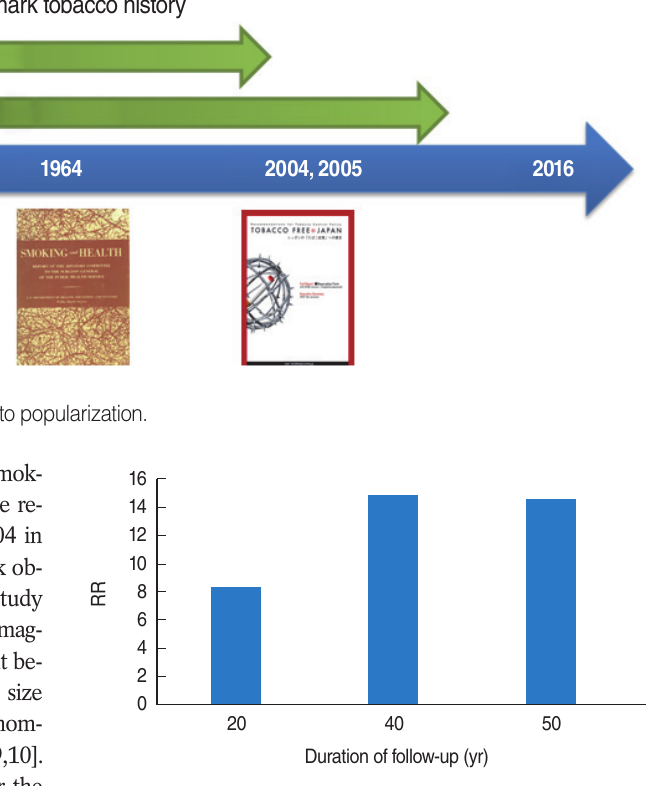
Figure 2. Relative risk (RR) of smoking for lung cancer, UK. Adapted from Doll et al.